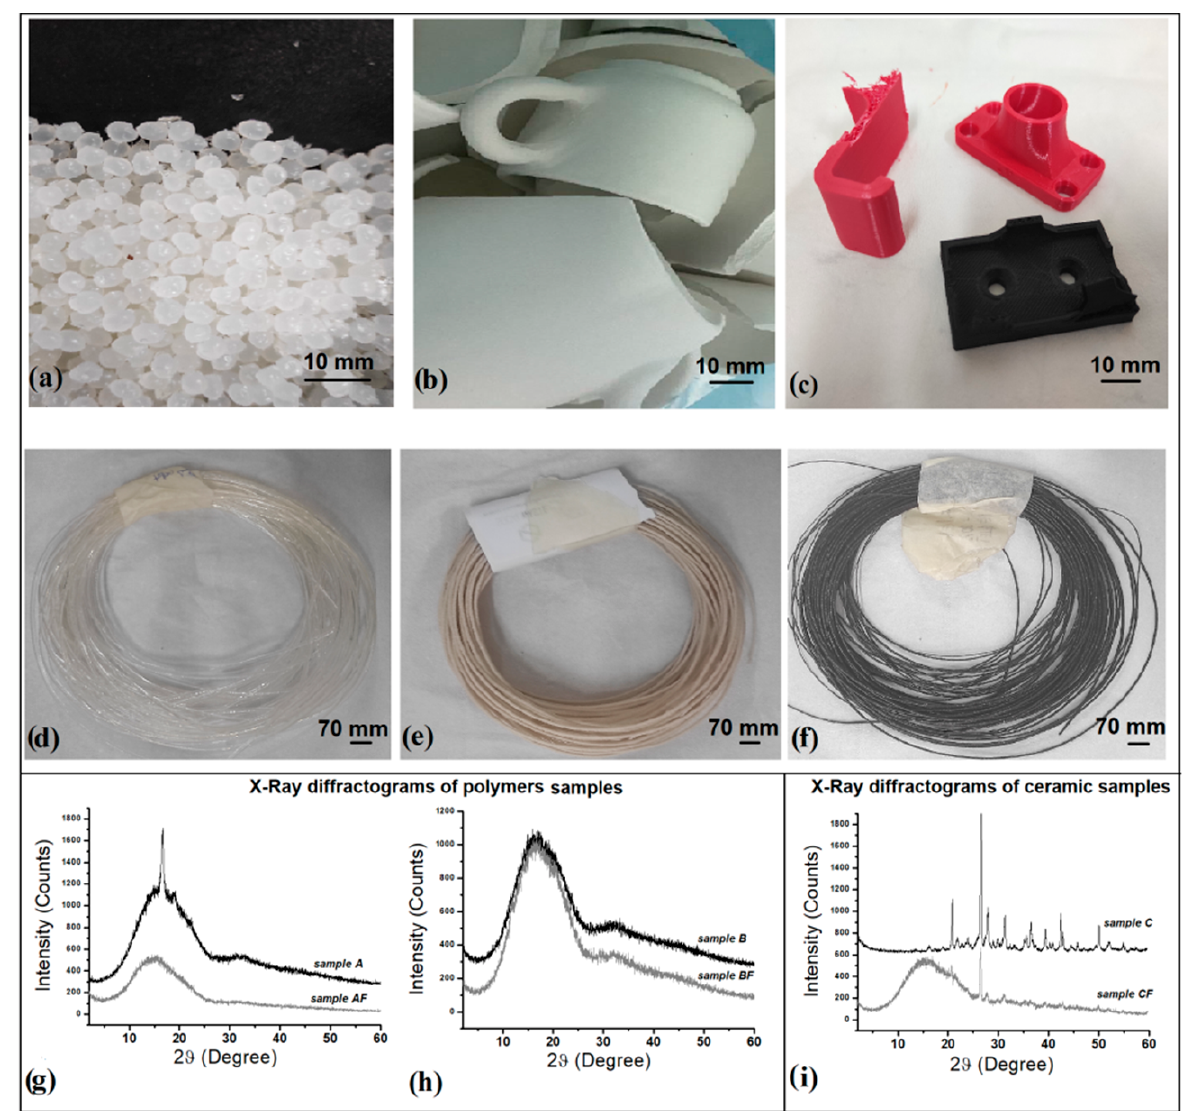
Figure 2. Images of the raw materials used in the production of composite filaments: ( a ) PLA Ingeo 4043D (A); ( b ) ceramic waste (C); ( c ) objects printed in PLA Sunlu (B). Images of filaments: ( d ) AF filament; ( e ) CF filament; ( f ) BF filament. X-Ray diffractograms of raw materials (polymers and filler) and of innovative green filaments developed in the work: ( g ) comparison of A and between the respective filament produced AF; ( h ) comparison of B and between the respective filament produced BF; ( i ) comparison of ceramic waste (C) and between the respective filament produced CF. Table 2. Thermal properties of polymers and percentage of crystallinity χ c (%).